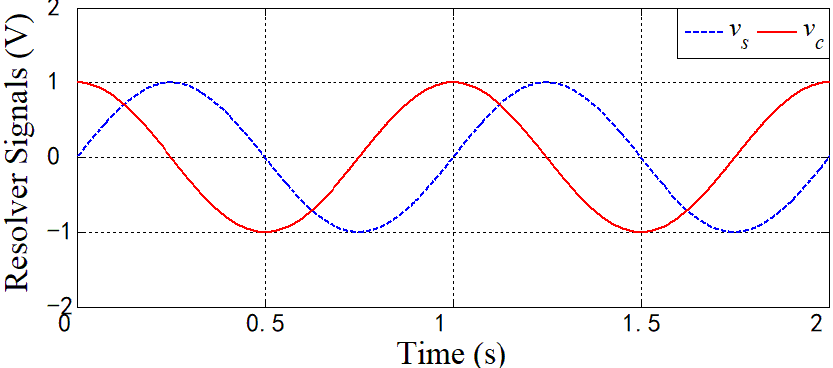
Figure 4. Resolver signals at fixed speed in simulation.